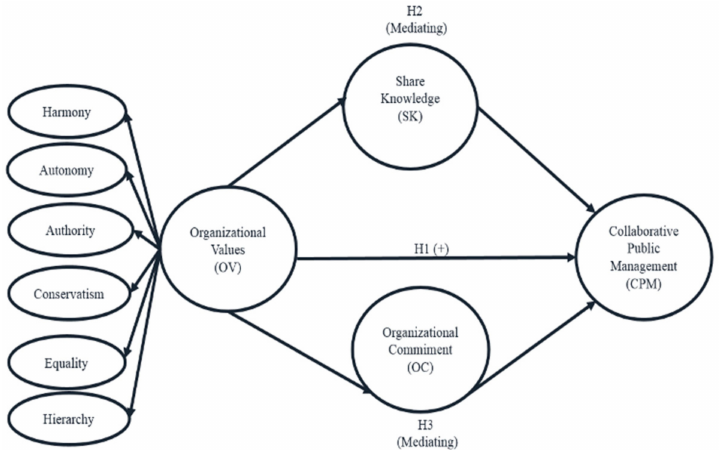
Figure 1. Research model and